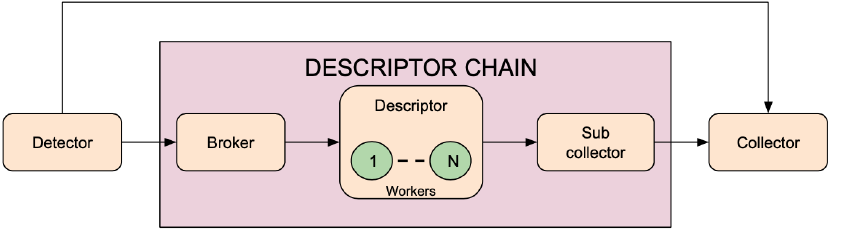
Figure 4. Components of a pipeline Descriptor Chain. A Descriptor Chain allows a scalable method of feature extraction distributing the messages coming from Detector across the N Descriptor workers. The Broker and the Sub Collector act, respectively, as a producer and a result collector in a push/pull messaging